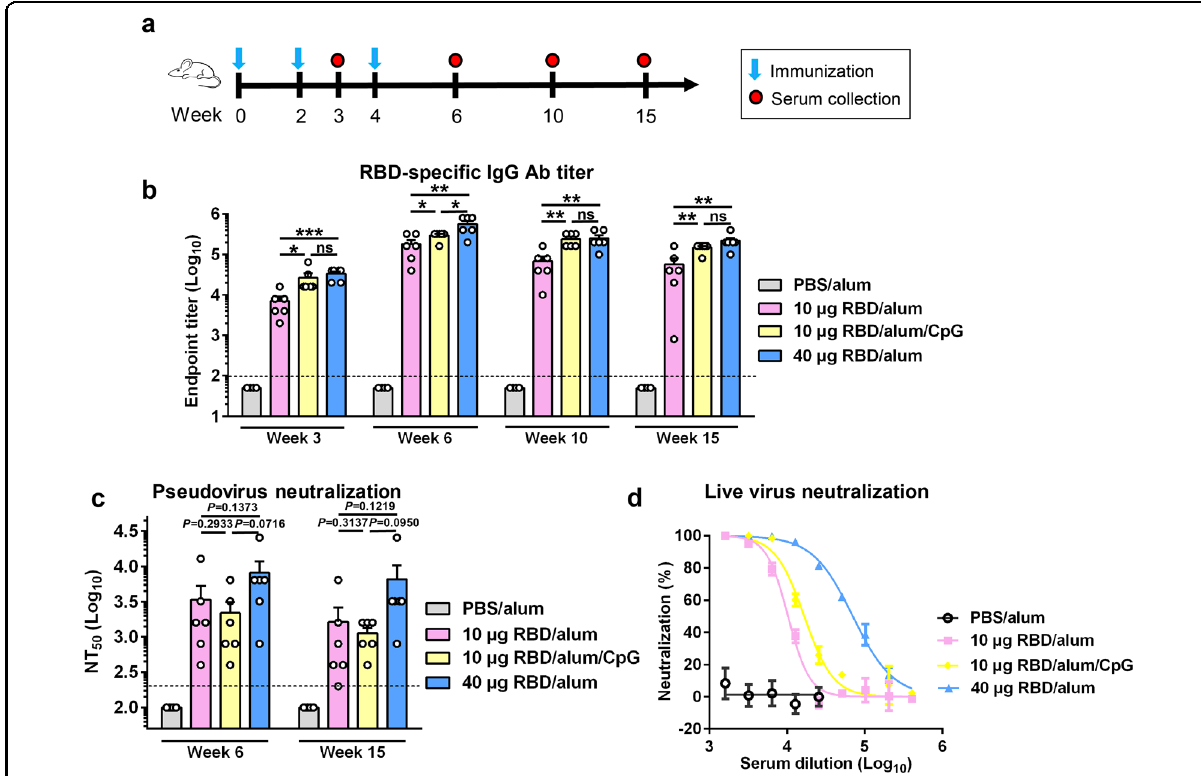
Fig. 3 Effects of antigen dose and adjuvant on immunogenicity of monomeric RBD. a Immunization schedule. Four groups of BALB/c mice were immunized with alum-formulated PBS (PBS/alum), 10 μ g of RBD formulated with alum (10 μ g RBD/alum), 10 μ g of RBD formulated with alum and CpG (10 μ g RBD/alum/CpG), or 40 μ g RBD/alum at weeks 0, 2, and 4. Antiserum samples were collected at weeks 3, 6, 10, and 15. b RBD-speci fi c serum antibody titers determined by ELISA. Binding titer below the lowest serum dilution (1:100; dashed line) was assigned a value of 50. c Neutralizing antibody titers (NT 50 ) of the antisera against SARS-CoV-2 pseudovirus. NT 50 below the lowest serum dilution (1:200; dashed line) was assigned a value of 100. Each symbol represents one mouse. d Neutralization activity of the pooled week-6 antisera against authentic SARS-CoV-2. Data are presented as means± SEM. P values were analyzed with unpaired t -test and indicated as follows: ns, not signi fi cant; * P < 0.05; ** P < 0.01; *** P <